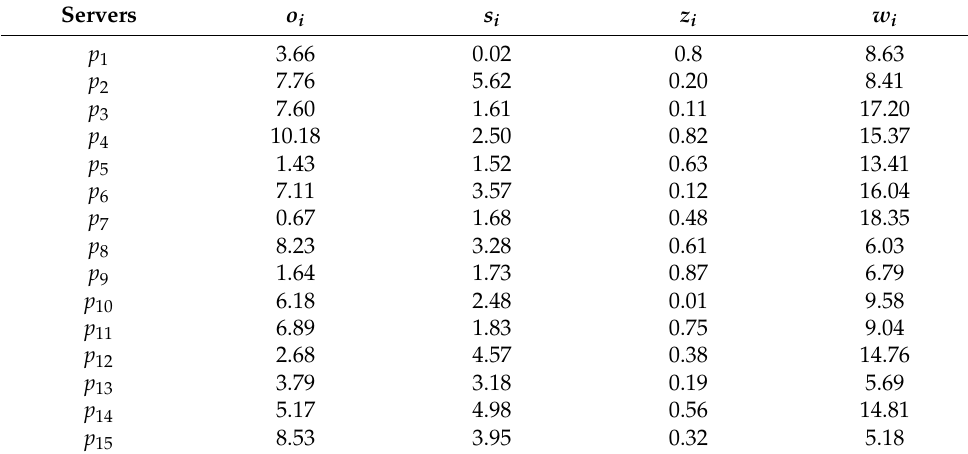
Table 2. Parameters of the heterogeneous networked computing